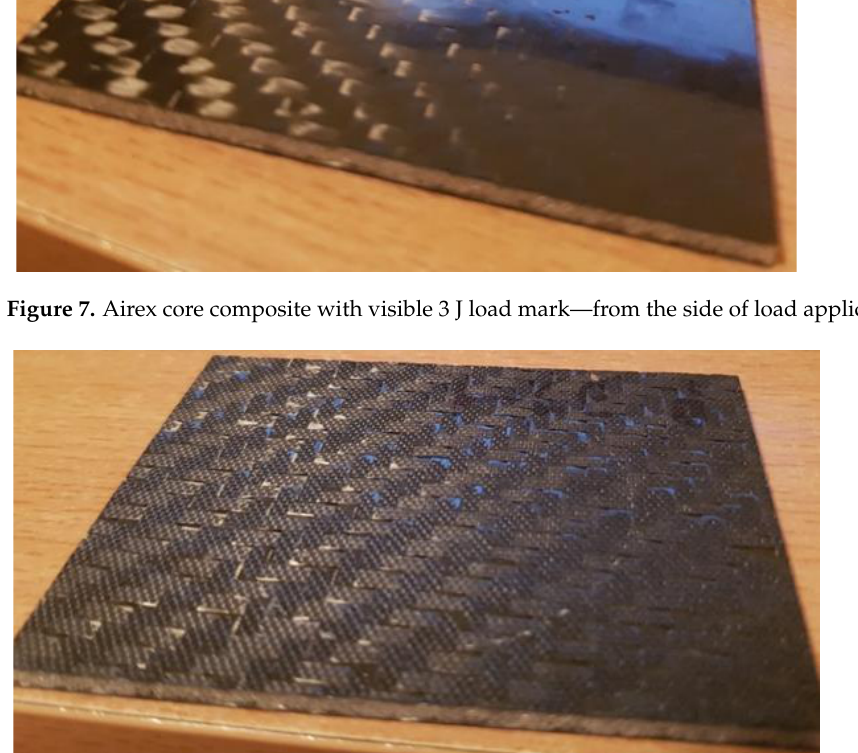
Figure 8. Composite with Airex foam core on the opposite side of the impact — energy 3 J.